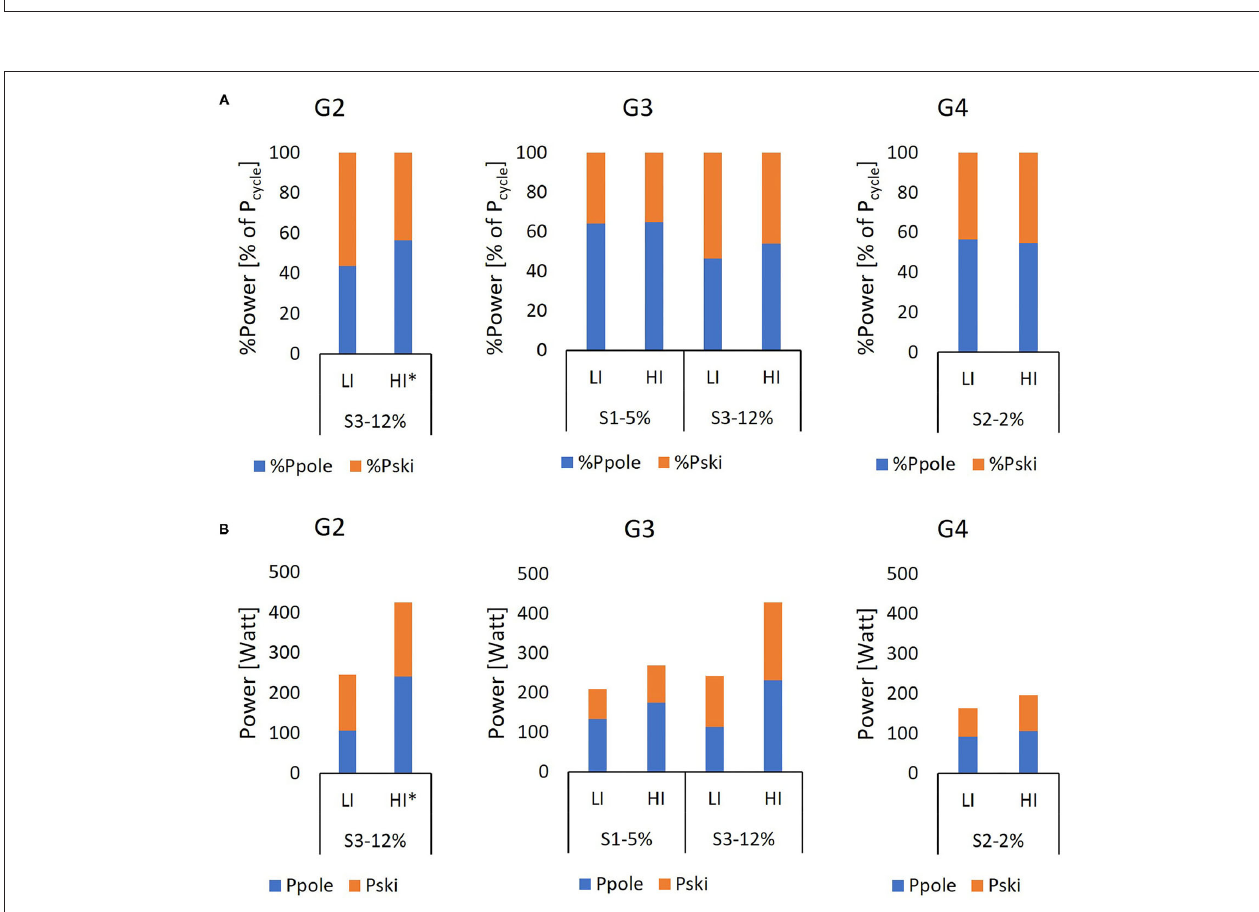
FIGURE 4 | Distribution of sub-techniques, in the percentage of the time, (A) as a function of the lap (i.e., L1–L7) and (B) as a function of segment (i.e., S1–S5), in the LI and HI sessions.